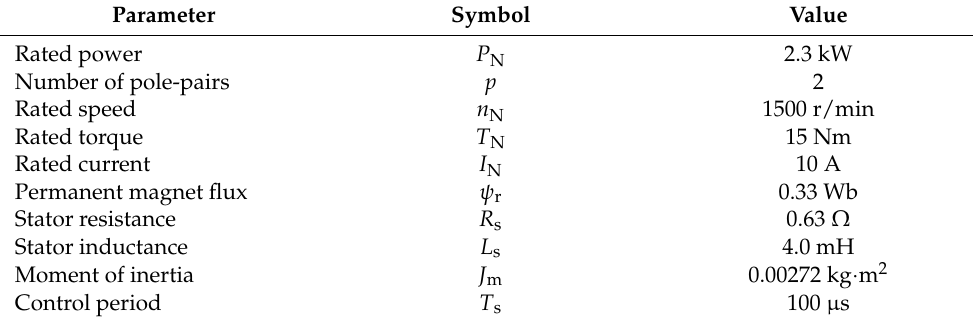
Table 1. PMSM parameters.